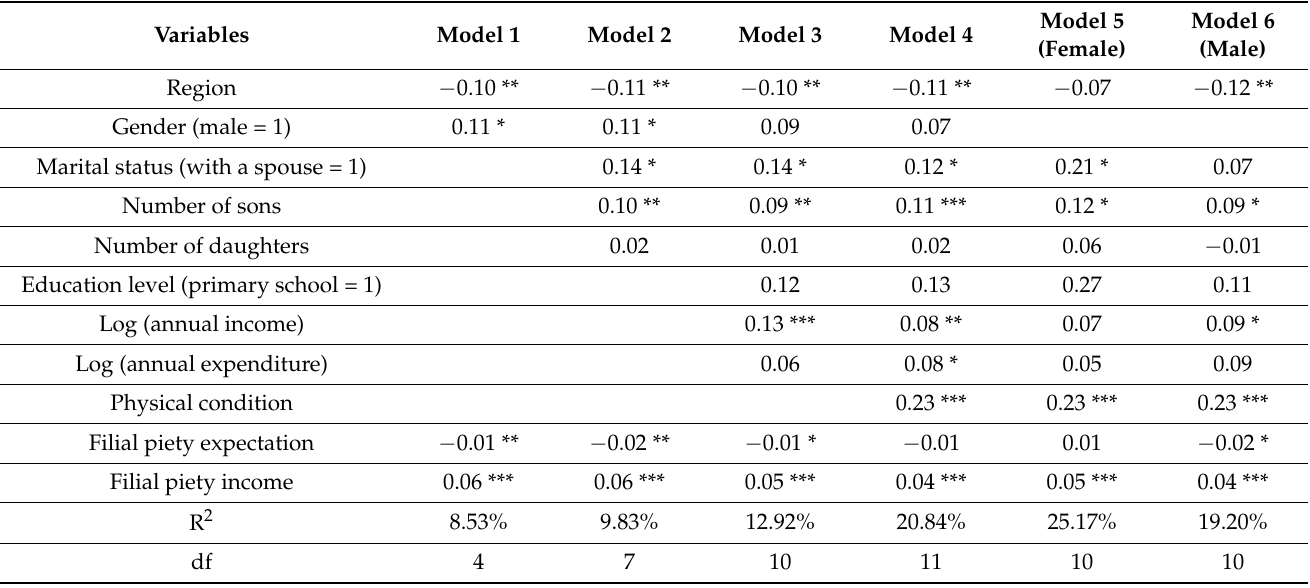
Table 3. Relationship between filial piety expectation, filial piety income, and life satisfaction of empty-nest elderly in rural